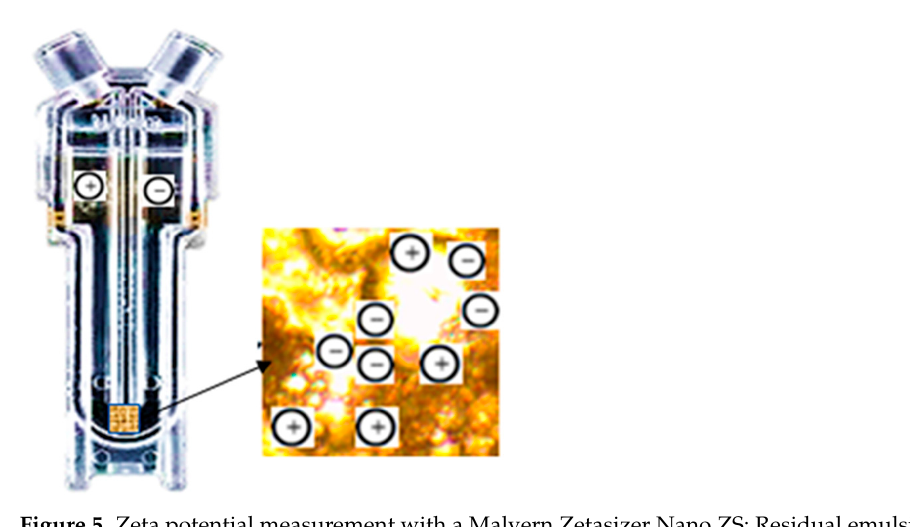
Figure 5. Zeta potential measurement with a Malvern Zetasizer Nano ZS: Residual emulsion in the capillary cell.